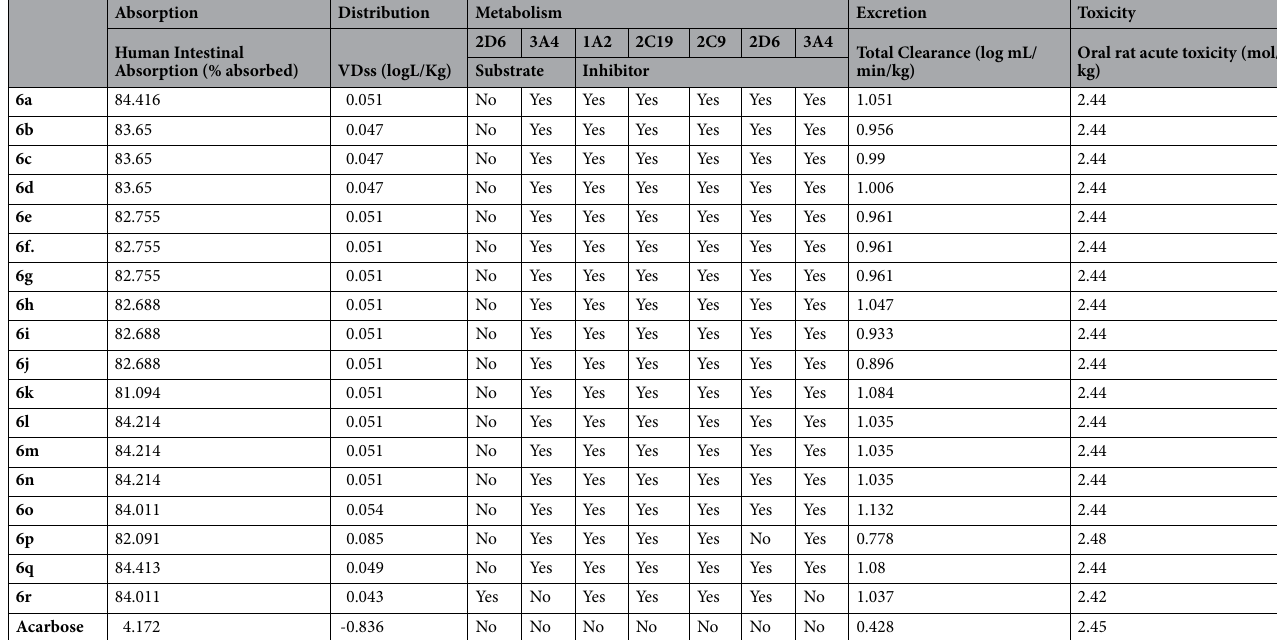
Table 3. ADMET prediction of the synthesized derivatives as α-glucosidase